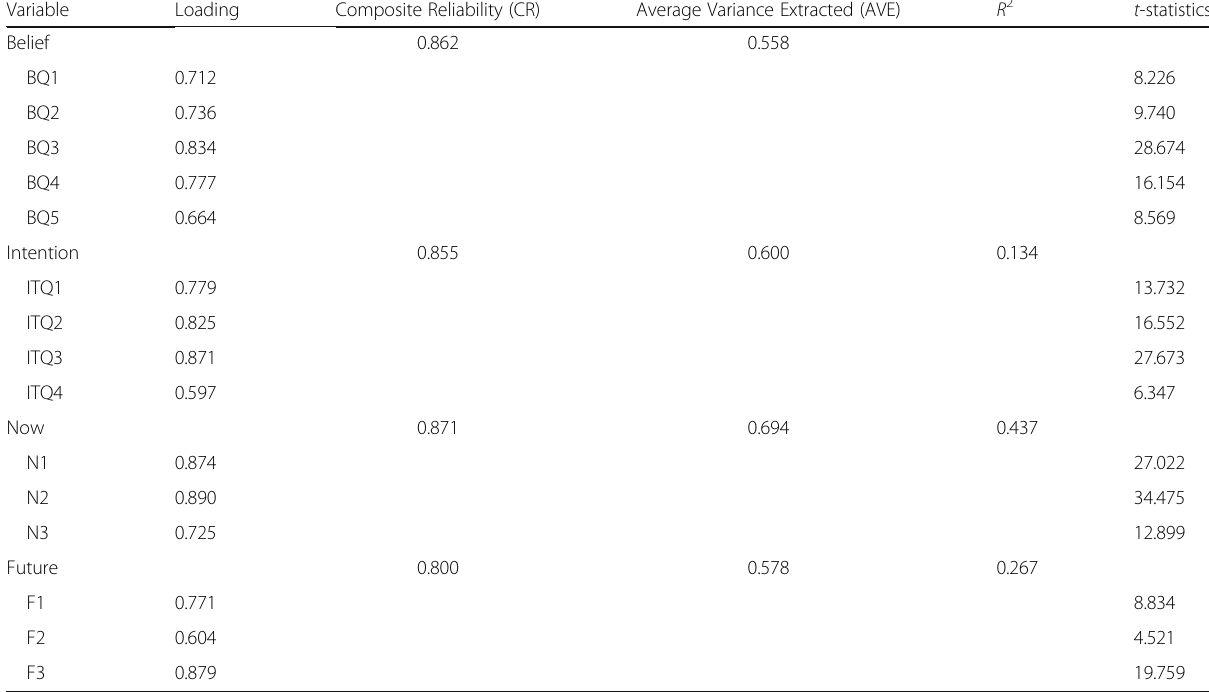
Table 7 Results summary of the SEM model Variable